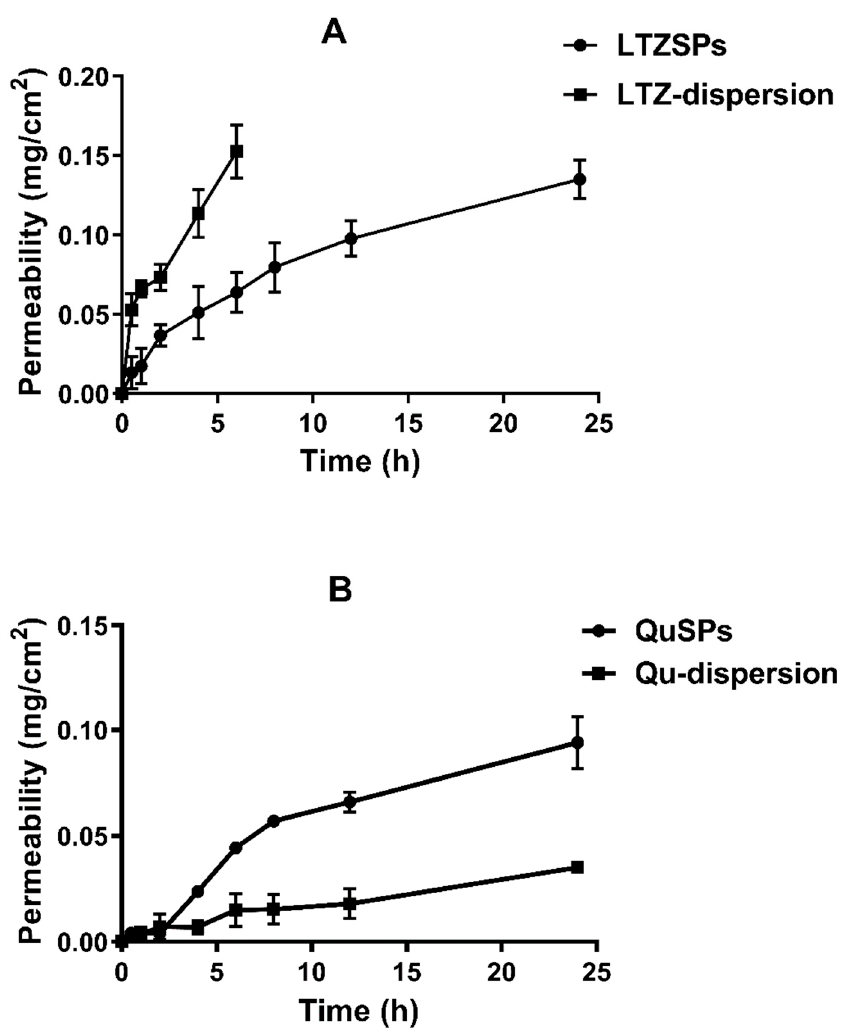
Figure 4. Ex vivo permeation profile of ( A ) The optimized LTZSPs (formulation L8), compared to free LTZ dispersion in hydroalcoholic PBS solution pH 7.4 at 37 ◦ C. ( B ) The optimized QuSPs (formulation Q5), compared to free Qu dispersion in PBS pH 7.4 plus 1% Tween 80 at 37 ◦ C. Data are presented as mean ± SD, n = 3. Abbreviations: LTZ; letrozole, Qu; quercetin, LTZSPs; letrozole-loaded spanlastics, QuSPs; quercetin-loaded spanlastics.